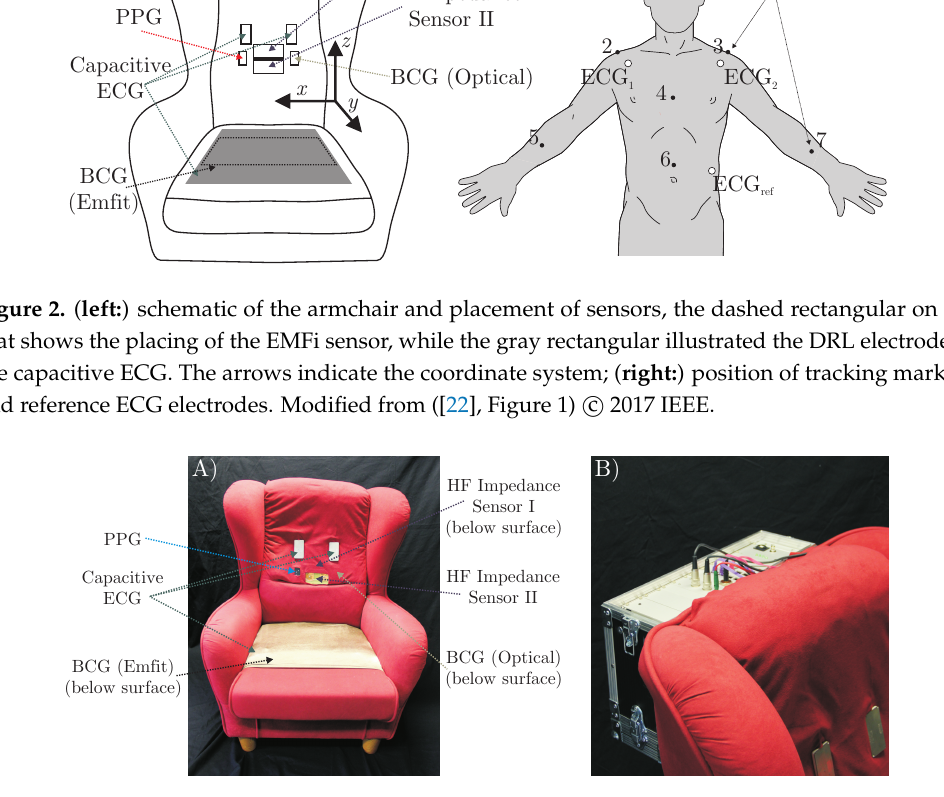
Figure 3. ( A ) photograph of “MuSeSe”; ( B ) closeup of the case containing analog and digital front-ends as well as the